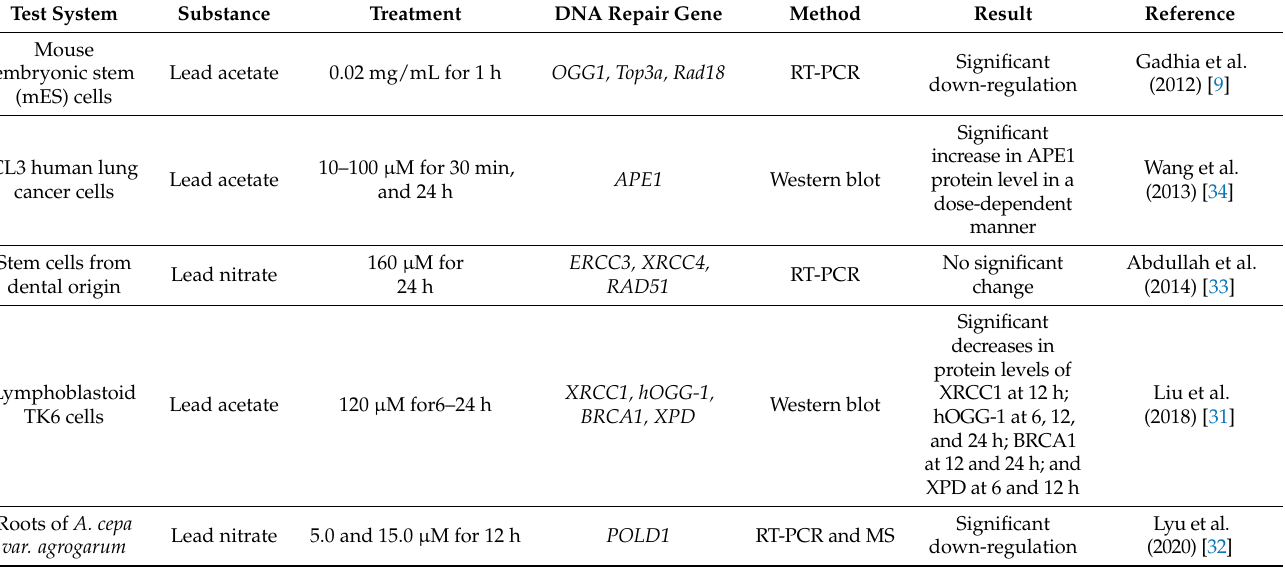
Table 1. In vitro studies on the effects of Pb on the expression of DNA repair-related genes.